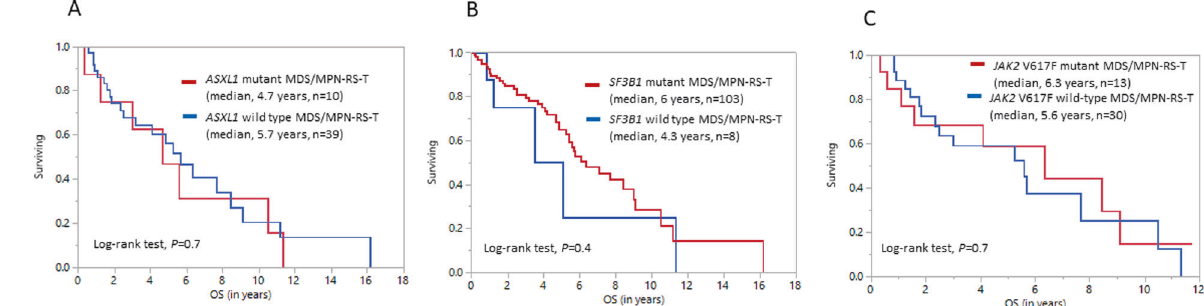
Fig. 1 Figure showing overall survival (OS) differences between ASXL1 , SF3B1 and JAK2 V617F mutated and wild-type MDS/MPN-RS-T patients. A shows that there is no signi fi cant Kaplan – Meier estimate of OS difference between ASXL1 mutated and wild-type MDS/MPN-RS-T patients [median OS, 4.7 (95% CI 0.3 – 10.5) versus 5.7 (95% CI 2.5 – 8.4) years, P = 0.7], B shows that there is no signi fi cant Kaplan – Meier estimate of OS difference between SF3B1 mutated and wild-type MDS/MPN-RS-T patients [median OS, 6.3 (95% CI 5.4 – 9) versus 4.3 (95% CI 0.8 – 11.3) years, P = 0.4], C shows that there is no signi fi cant Kaplan – Meier estimate of OS difference between JAK2 V617F mutated and wild-type MDS/ MPN-RS-T patients [median OS, 6.3 (95% CI 1.1 – 9.1) versus 5.6 (95% CI 2.3 – 10.5) years, P = 0.7].